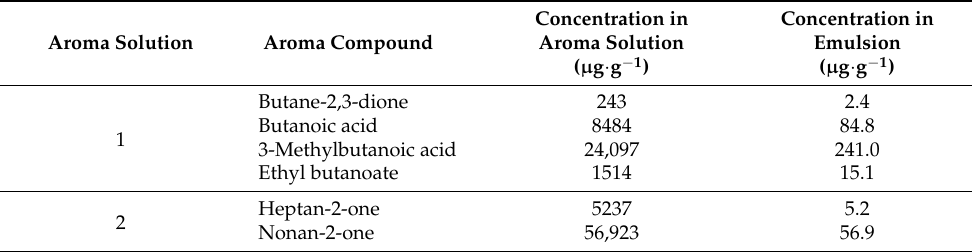
Table 2. Concentrations of aroma compounds in aroma solutions 1 and 2 and the resulting final concentrations in the